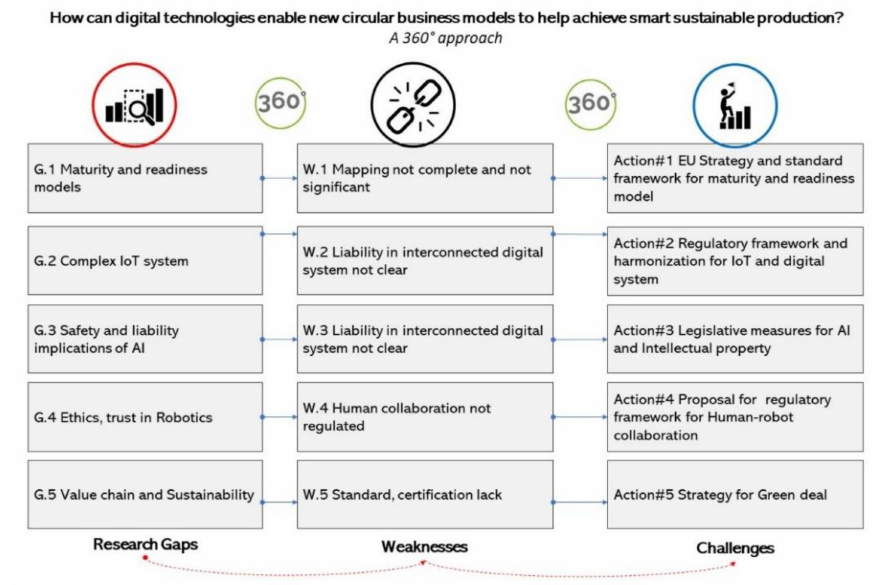
Figure 11. Gaps, weaknesses, and